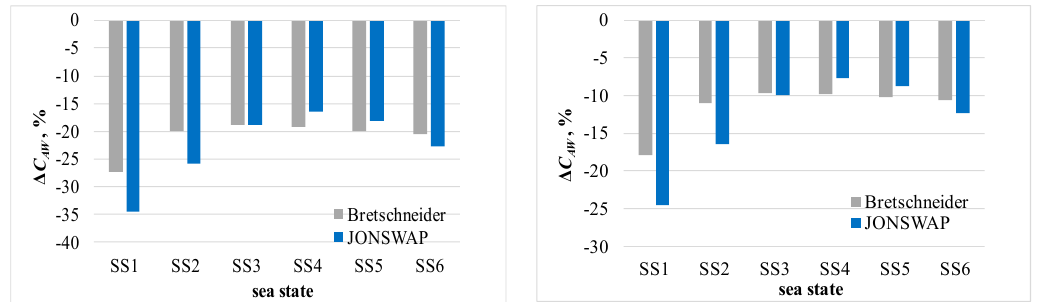
Figure 10. Influence of speed on added resistance coefficient in irregular waves: 20 knots (left) and 22 knots (right).